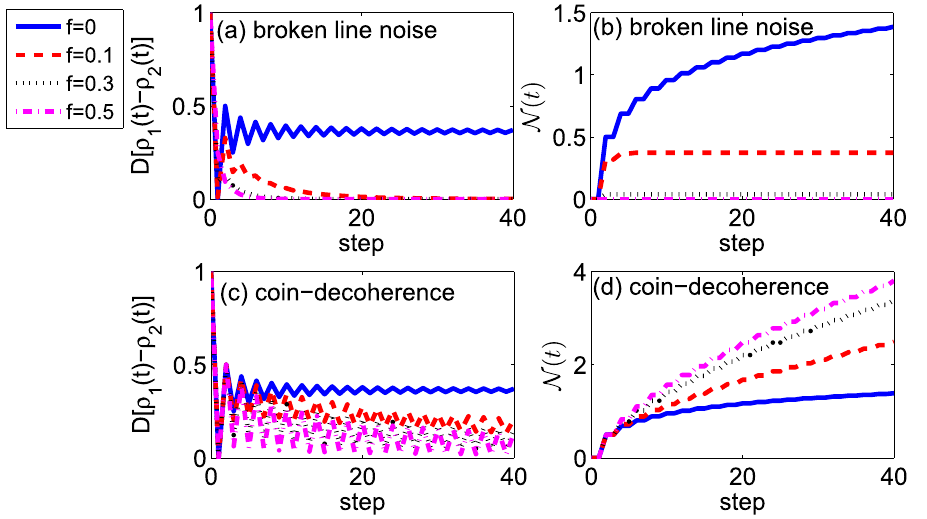
Figure 4. The two dimensional QW with different strengths of decoherence. Blue solid, f = 0; Red dashed, f = 0.1; Black dotted, f = 0.3; Magenta dotted dashed, f = 0.5. ( a , b ) The broken line noise is considered in the walk. ( a ) The trace distance between the coin states ρ 1 ( t ) and ρ 2 ( t ). The initial coin states are chosen as ρ = R R (0) and ρ = L L (0) . ( b ) The non-Markovianity of the coin with the step evolution in the walk. 1 2 ( c , d ) The coin-decoherence appears in the walk. ( c ) The trace distance between the coin states ρ 1 ( t ) and ρ 2 ( t ). The initial coin states are chosen as ρ = R R (0) and ρ = L L (0) . ( d ) The non-Markovianity of the coin 1 2 with the step evolution in the